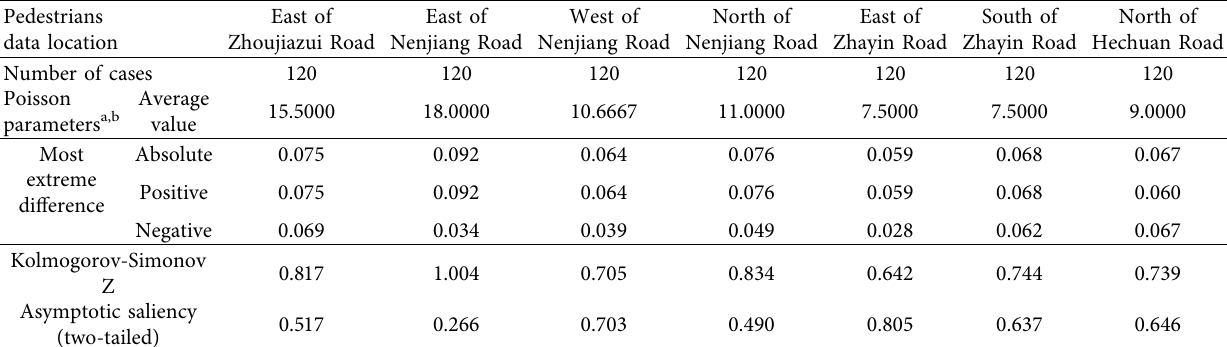
Table 3: Results of Kolmogorov-Smirnov test.